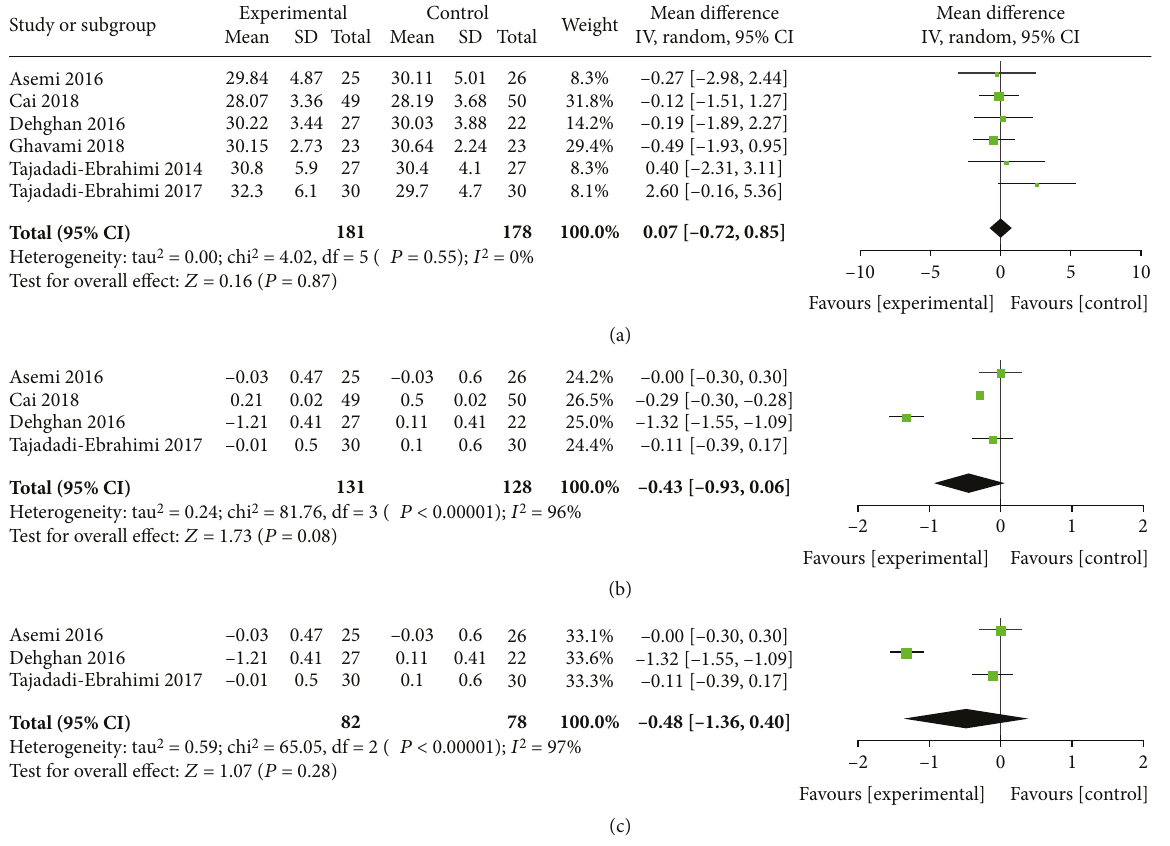
Figure 3: Findings of a meta-analysis of studies with continuation data on improvement in BMI for ITC vs. control groups, in terms of estimated MD and 95% CI. (a) Postintervention data of BMI, (b) reduction data of BMI, and (c) subgroup analysis for reduction data according to the baseline BMI